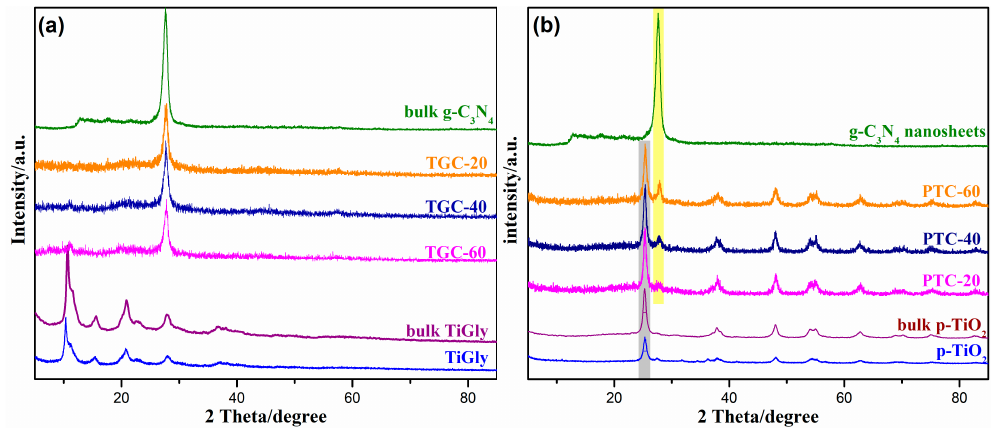
Figure 1. ( a ) XRD pattern of bulk g-C 3 N 4 , bulk and nanoparticle TiGly and TGC- x before calcination; ( b ) XRD pattern of g-C 3 N 4 nanosheets, bulk and nanoparticle p-TiO 2 and PTC- x after